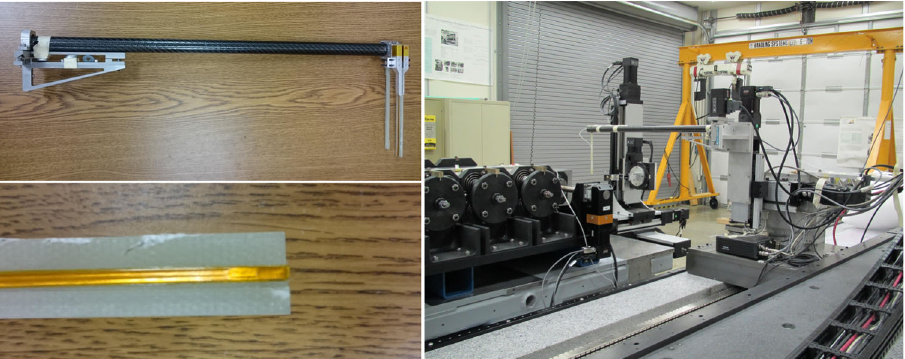
FIG. 15. The lower left panel shows one of the Capacitec sensors used to measure the gap profile. The Capacitec holder is shown in the top left panel. On the right, the sensors are shown installed and ready for use in the APS magnetic measurement